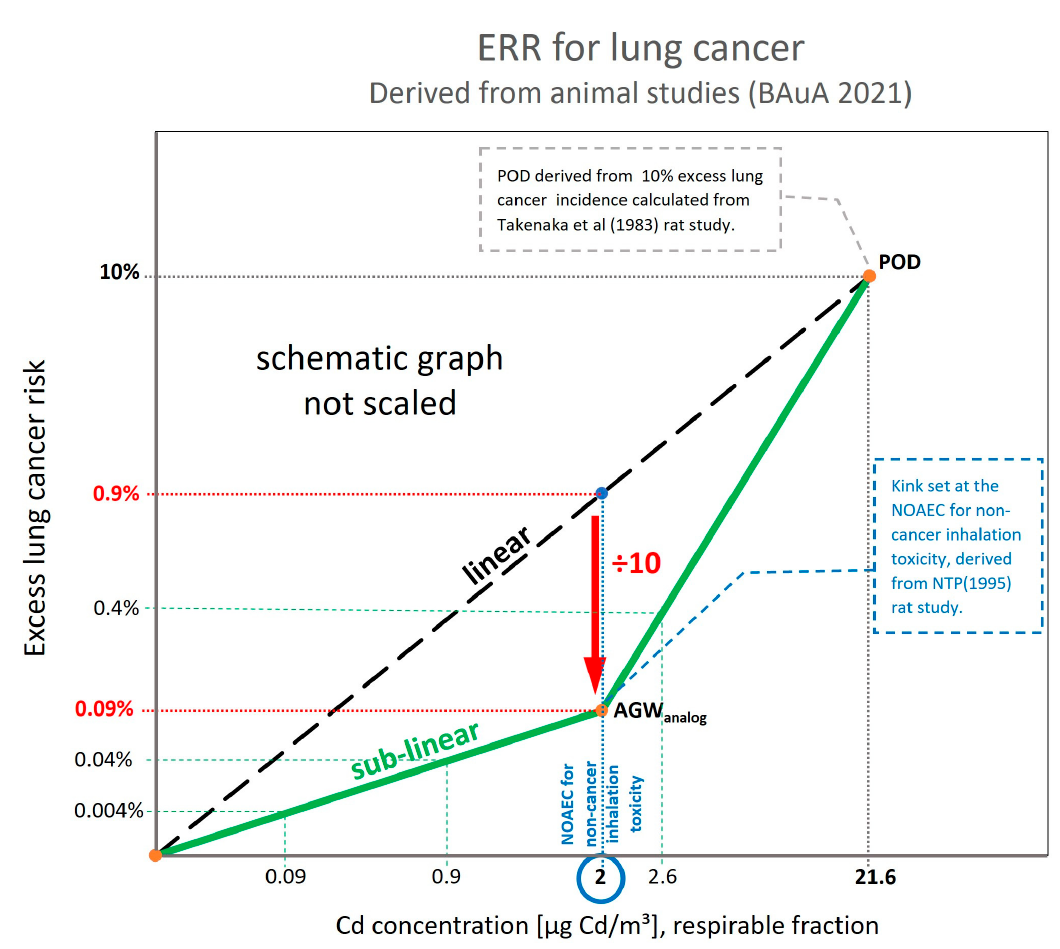
Figure 1. Exposure Risk Relationship (ERR): hockey-stick shape (lung cancer, cadmium), respirable fraction (adapted from BAuA (2021)